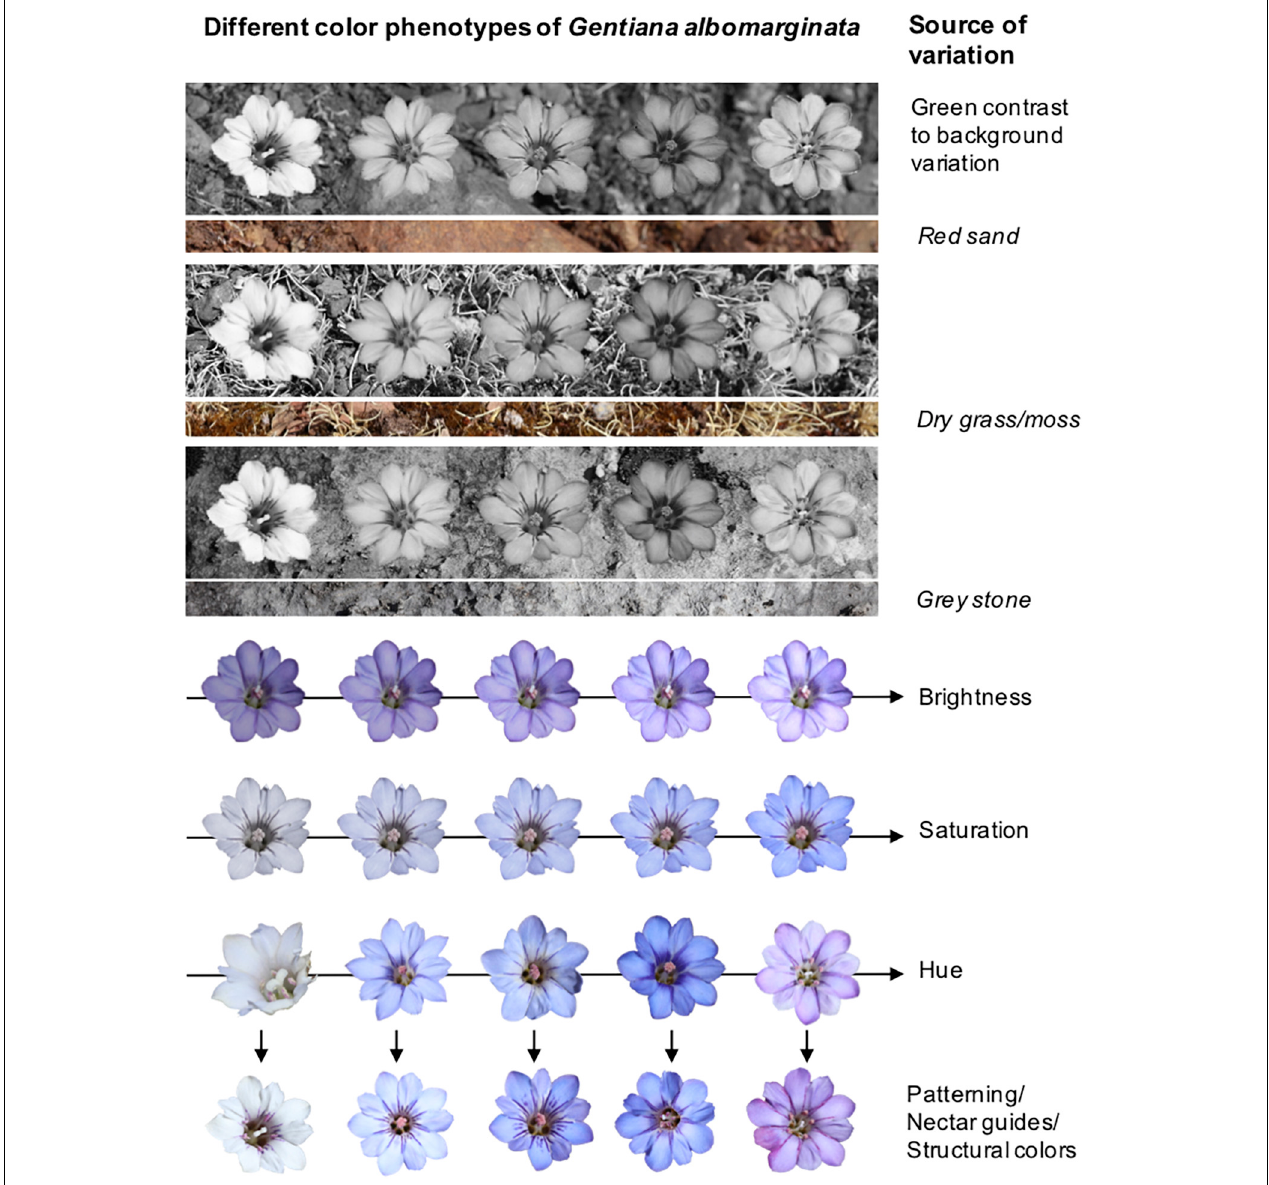
FIGURE 2 | Representation of possible sources of variation in the color appearance of flowers exemplified in the alpine herb Gentiana albomarginata as a potential pollinator approaches flowers from far to near. Upper panels: Variation in green contrast between differently colored flowers and different backgrounds as a result of longwave photoreceptor perception. Lower panels: Variation in hue, saturation and brightness, which can be further modulated by variation in petal color patterning and nectar guides, or by variation in structural colors as here the presence and absence of fluorescent purple-colored pollen presented in male but not in female phase